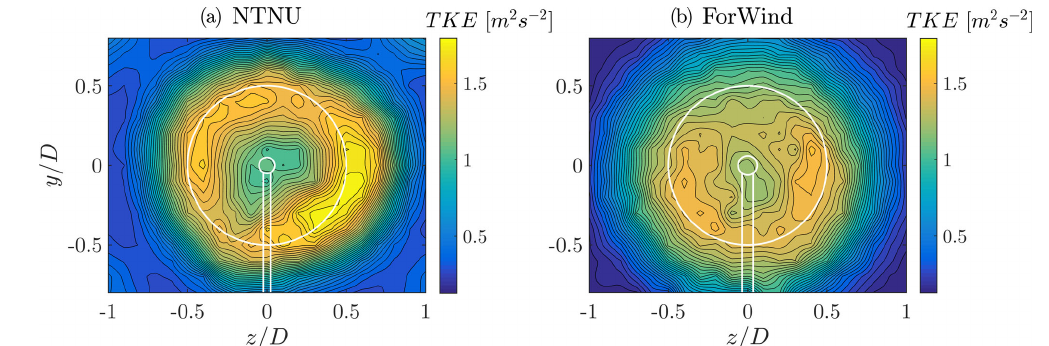
Figure 6. Turbulent kinetic energy (TKE) in m 2 s − 2 according to Eq. (4) for γ = 0 ◦ . (a) NTNU turbine, (b) ForWind turbine.